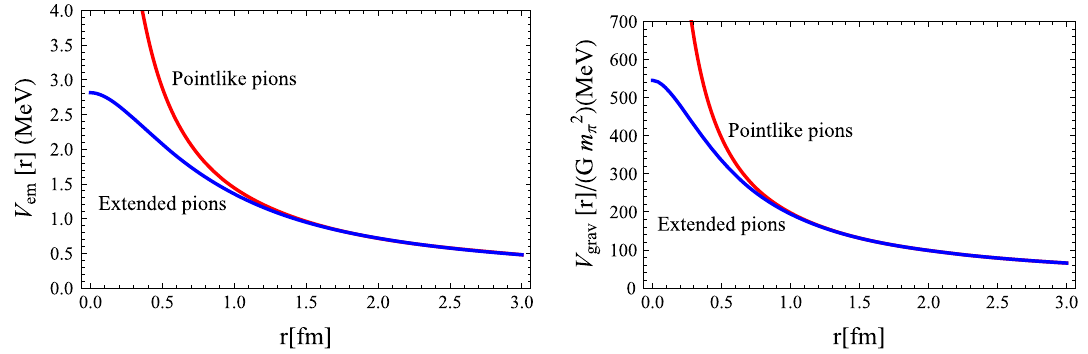
Fig. 4 Effective elementarity of the pion. We show the Electrostatic (left panel) and gravitational (right panel) potentials for ππ interactions and compare the point-like limit (red line) with the finite size case (blue